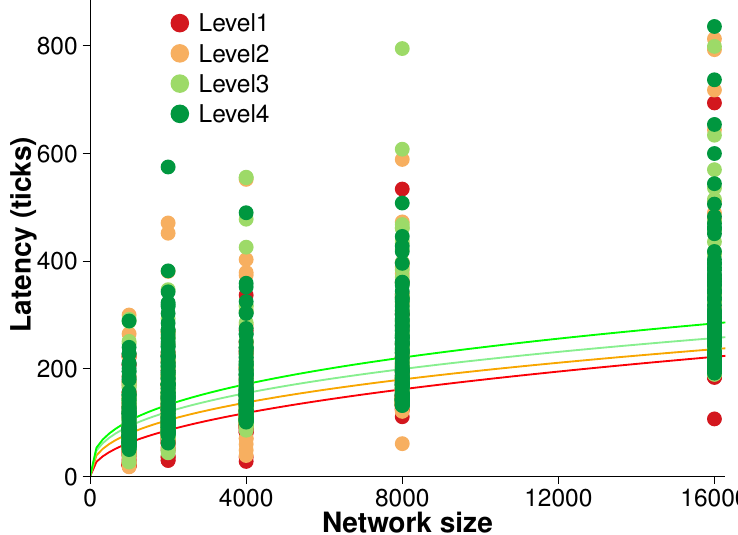
Figure 8. Latency (averaged over 10 randomized networks and 10 consecutive